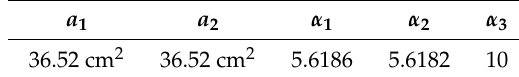
Table 1. Parameters of the simulated Coupled Tanks System.